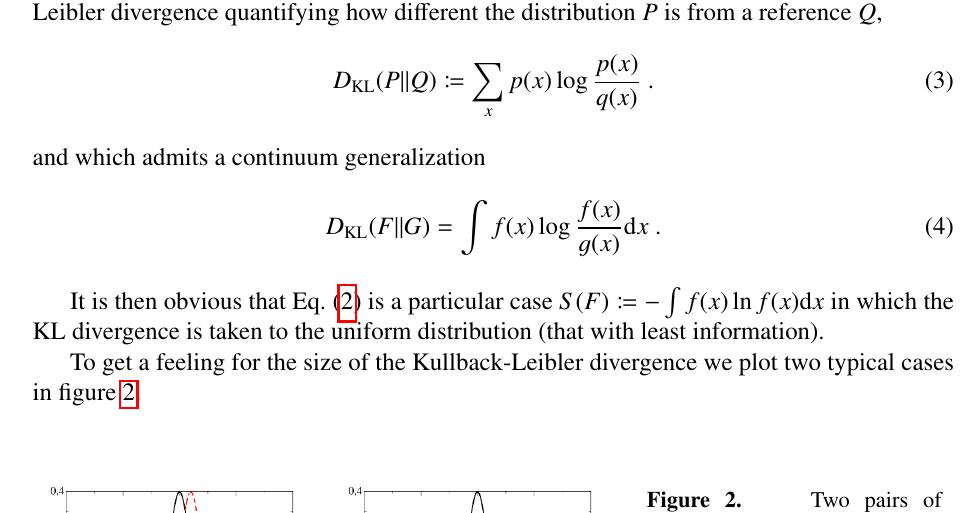
Figure 2. Two pairs of Gaussian functions with widely di ff erent Kullback-Leibler diver- gences, D KL = 0 . 12 for the left pair of similar distributions, and D KL = 1 . 63 for the right one.